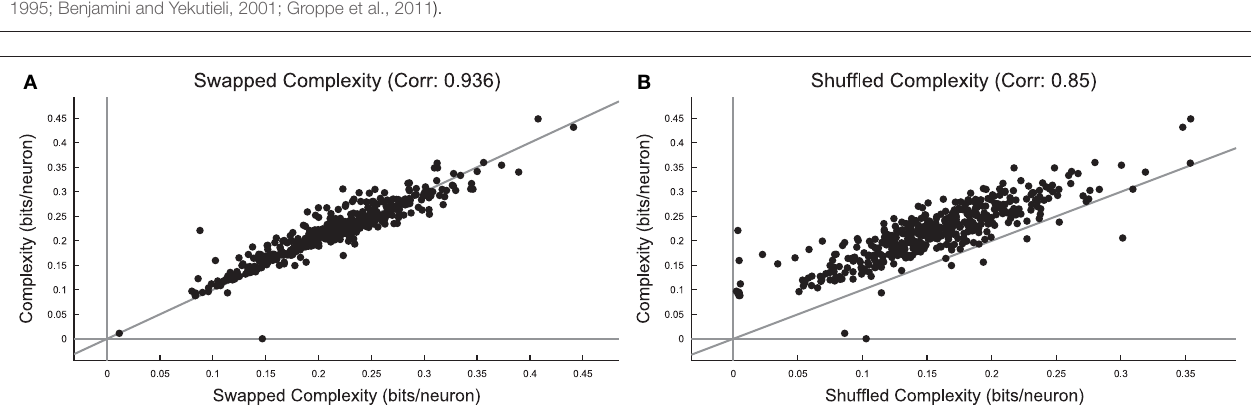
FIGURE 11 | Markers of criticality decreased under randomization in culture data. (A) The size power-law fit range decreased under randomization, with the exception of the 10 bin jittering. (B) The size power-law fit exponent τ increased under randomization indicating the size distribution became steeper. (C) The duration power-law fit range decreased under randomization, with the exception of the 10 bin jittering. (D) The duration power-law fit exponent α increased under randomization indicating the duration distribution became steeper. Note that the fit results were not expected to change under spike swapping or shuffling because those randomization methods preserved avalanche profiles. Box Plots: minimum value, 25th percentile, median, 75th percentile, maximum value. Rank Sum Test: ( p < 0.05) 1 star, ( p < 0.01) 2 stars, and ( p < 0.001) 3 stars. Multiple comparisons correction performed using false discovery rate control ( Benjamini and Hochberg, 1995; Benjamini and Yekutieli, 2001; Groppe et al., 2011).